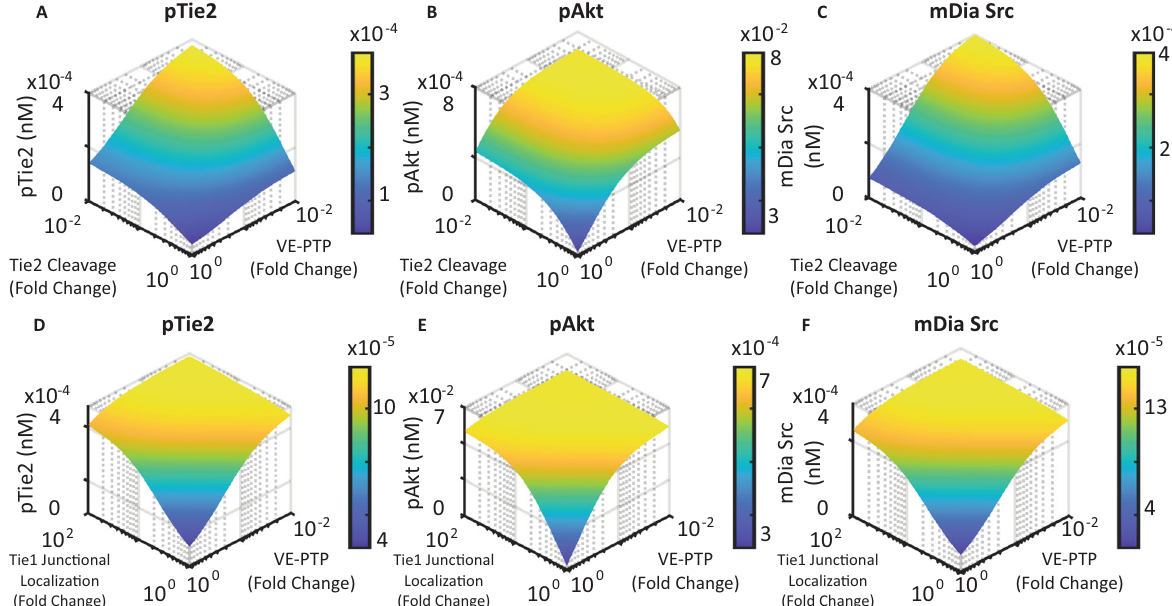
Fig. 7 Inhibiting Tie2 ’ s cleavage, promoting Tie1 ’ s localization to the junction, and inhibition of VE-PTP synergistically enhance Tie2 activation and downstream signaling. A – C Inhibition of Tie2 cleavage and VE-PTP, D – F promoting Tie1 ’ s junctional localization and inhibition of VE-PTP synergistically enhances Tie2 activation, Akt activation, and Src